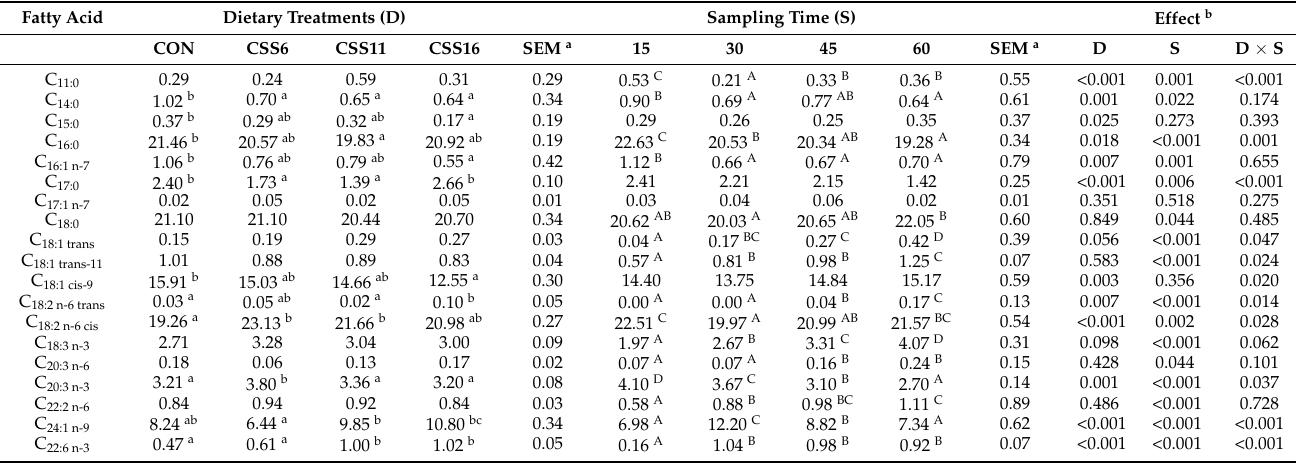
Table 3. The mean individual fatty acids (FA) (% of total FA) in the blood plasma of ewes fed diets (CON, CSS6, CSS11, and CSS16) with different levels of Camelina seeds (6%, 11%, and 16% of concentrate) throughout the experimental period (15th, 30th, 45th and 60th experimental